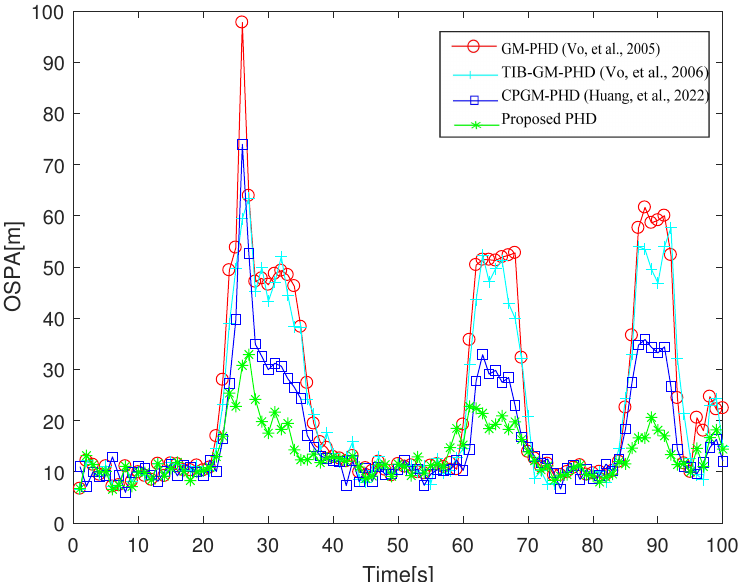
Figure 12. Comparison of OSPA distance between GM-PHD, TIB-GM-PHD, CPGM-PHD and Pro- posed PHD (The numbers in brackets represent references to various PHD methods).